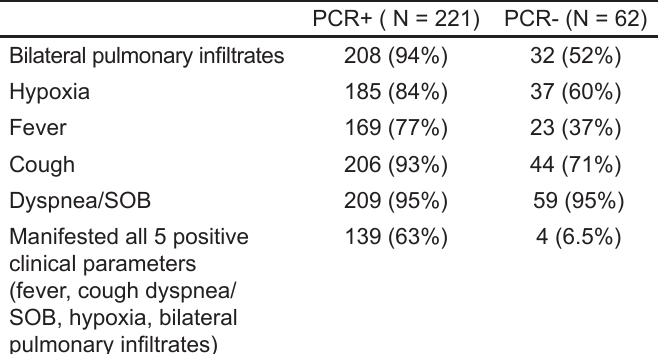
Table 3. Distribution of protocol clinical parameters based on COVID-19 PCR test